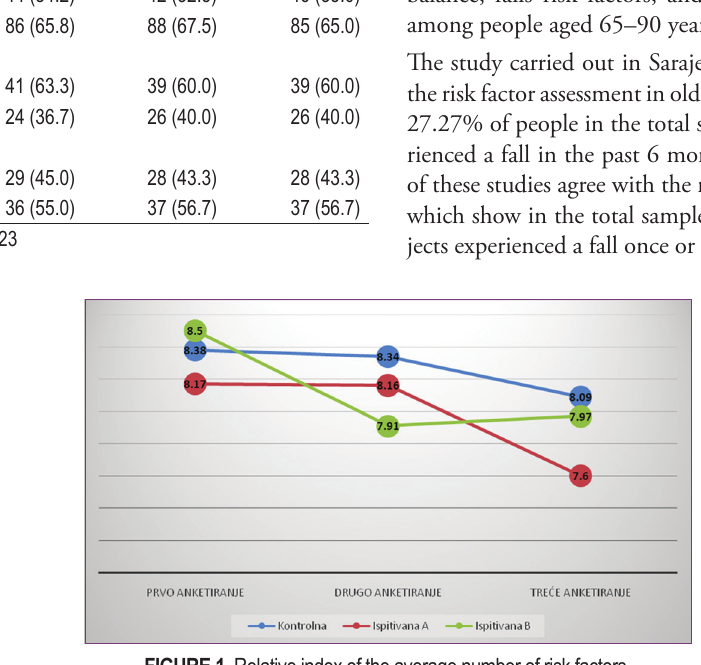
FIGURE 1. Relative index of the average number of risk